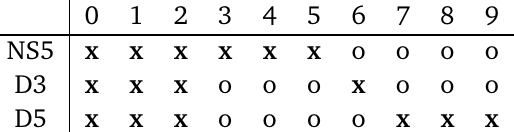
Table 1: Brane realization of 2 + 1 dimensional quiver gauge theories and their